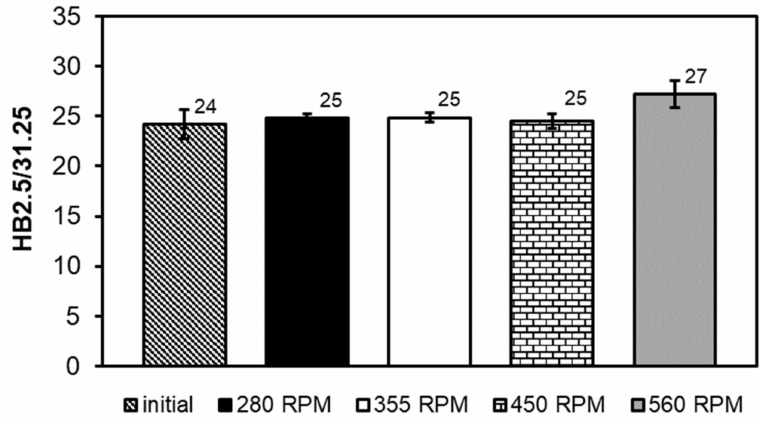
Figure 7. Comparison of hardness of SnSb11Cu6 alloy before and after